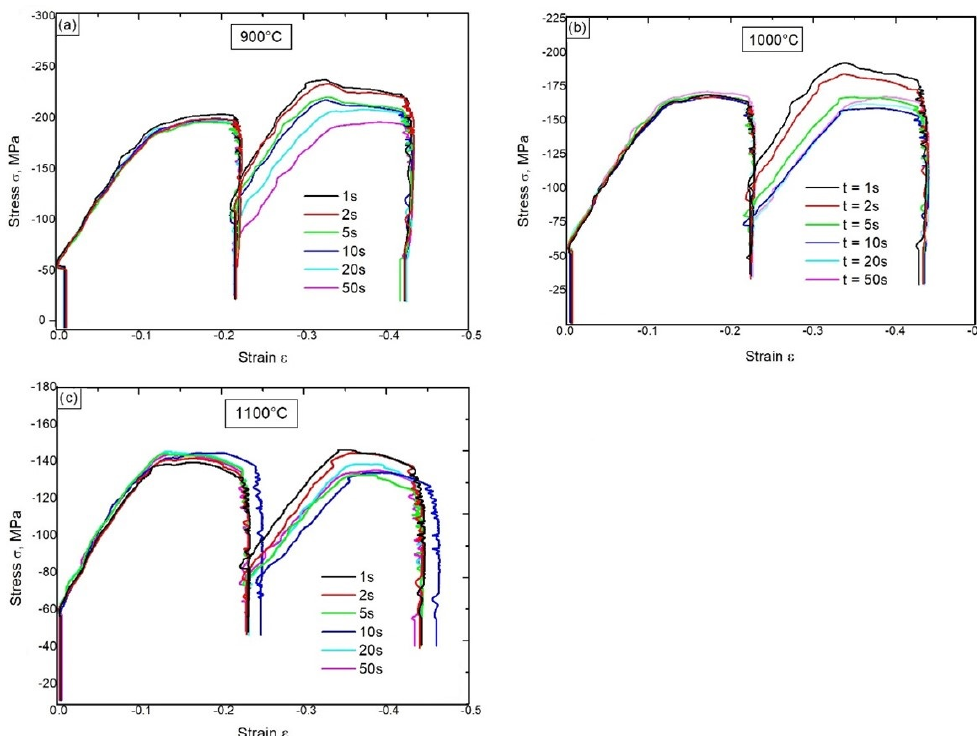
Figure 4. The σ – ε curves obtained during the two-stage compression at the rate of 10 s − 1 with the use of intervals between successive stages of deformation of 1 s, 2 s, 5 s, 10 s, 20 s and 50 s; the temperature: 900 °C ( a ), 1000 °C ( b ), 1100 °C ( c ).